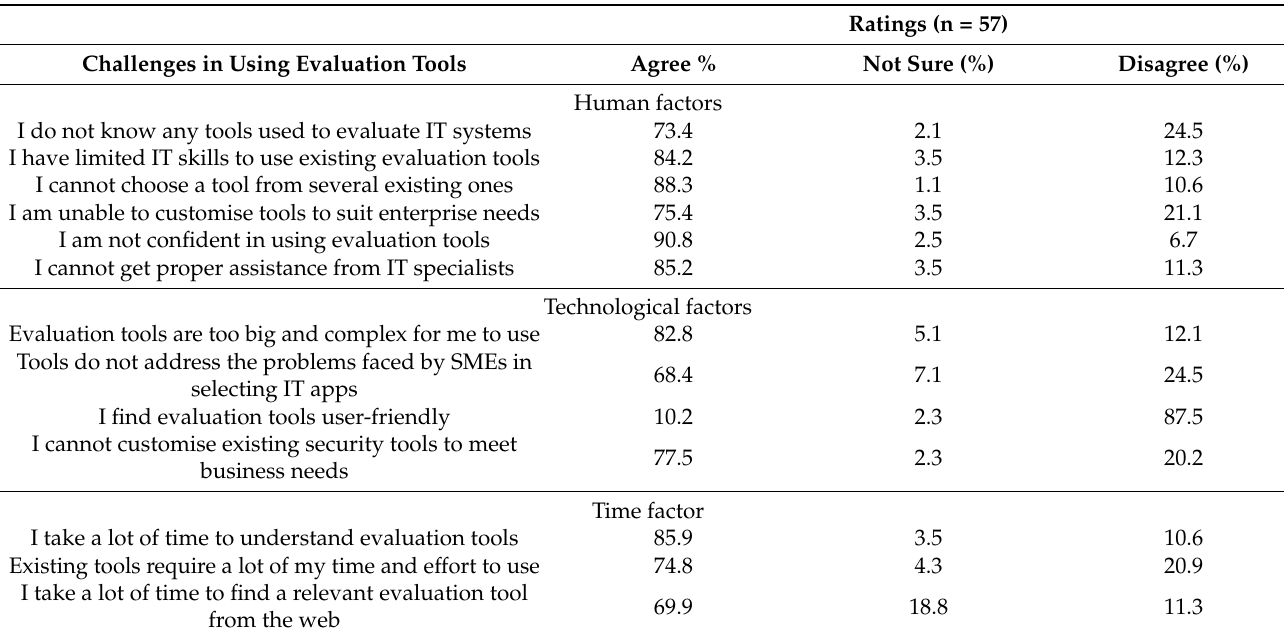
Table 3. Challenges faced in using existing security frameworks and